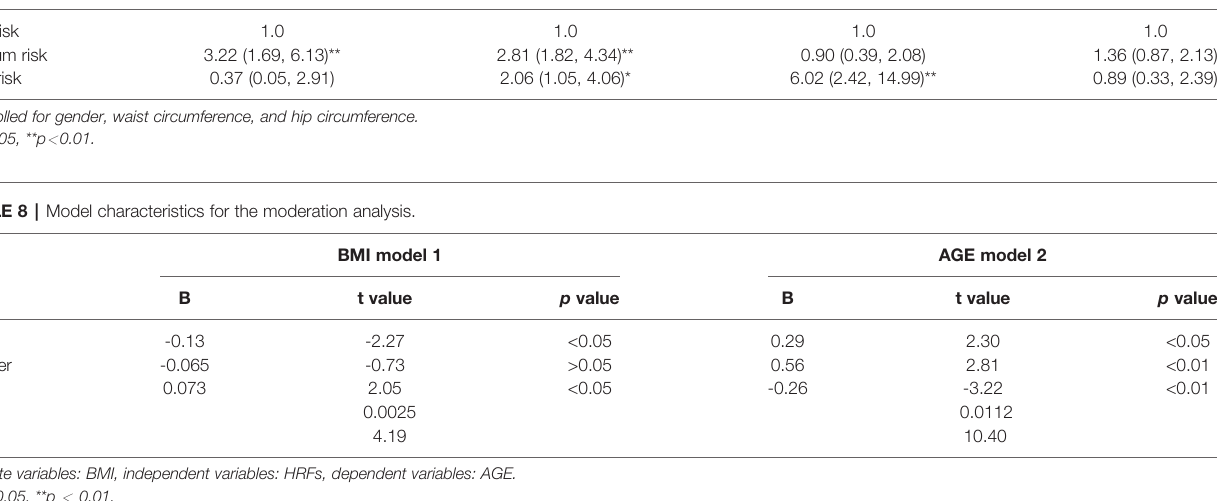
TABLE 7 | The multilevel logistic regression of risk factors and BMI by gender. Male